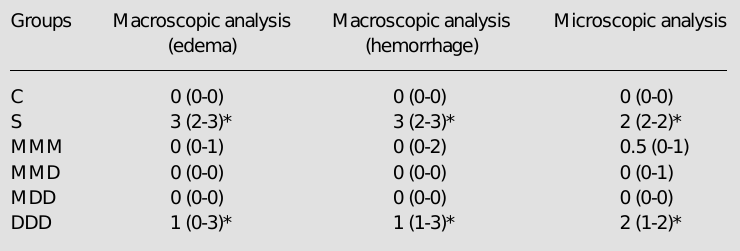
Table 1 - Macroscopic and microscopic analysis of the effects of dexamethasone in cyclophosphamide-induced hemorrhagic